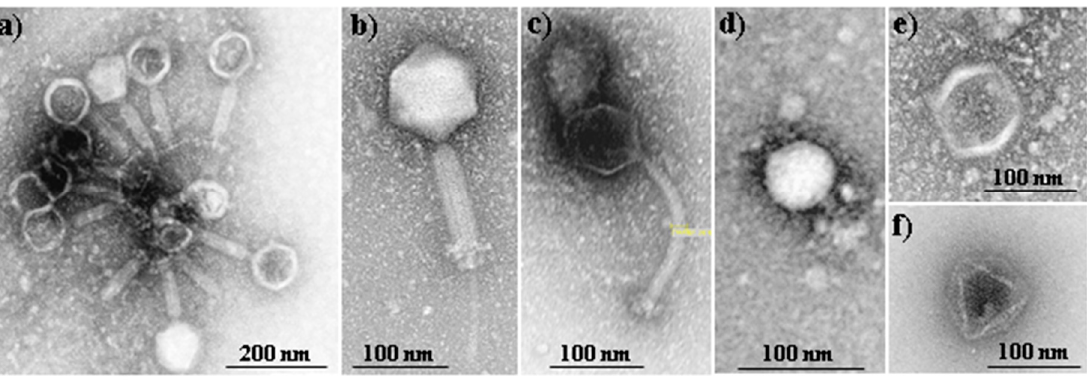
Figure 2. TEM micrographs showing the morphology of Fersis commercial bacteriophages ( a ) and Myoviridae ( b ), Siphoviridae ( c ), Podoviridae ( d ) and Leviviridae ( e , f ) bacteriophages that form part of the Phagestaph commercial preparation.